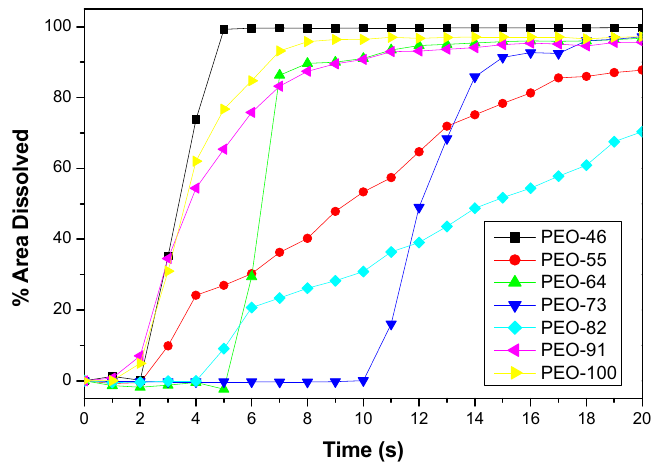
Figure 11. Dissolution profiles of blow spun PEO mats at different solvent compositions